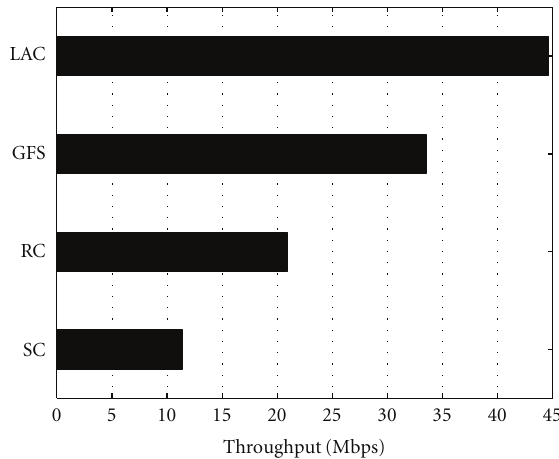
Figure 10: Total network throughput supporting di ff erent types of tra ffi c.